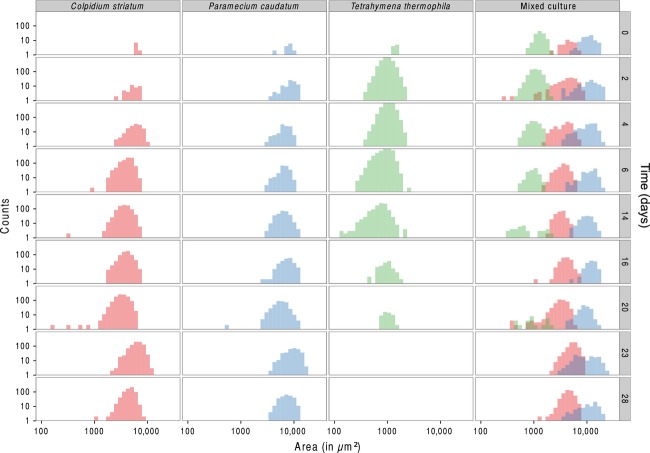
Body size changes through time (from first row to last row) in the mono- and mixed cultures during the experiment. At day 20, the medium was partly replaced by fresh medium perturbing the mono- and mixed cultures. Both axes are on log10 scaling.